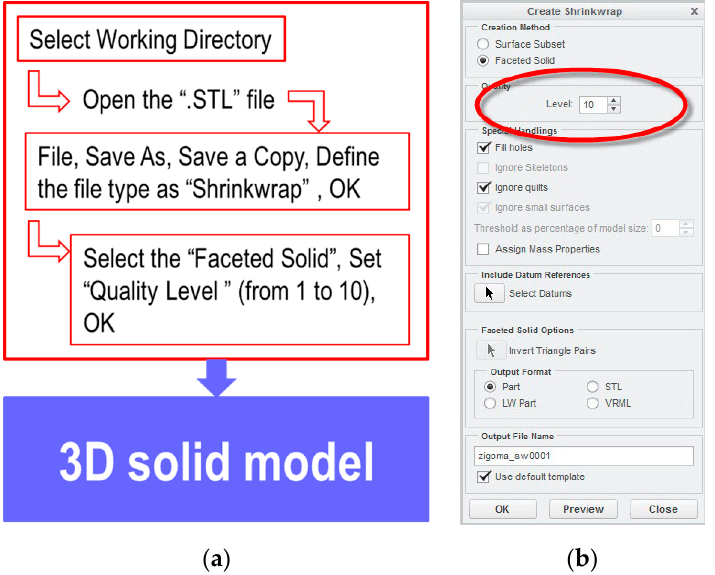
Figure 4. Steps for converting the STL files into 3D solid models using Creo: ( a ) stages of conversion using the Shrinkwrap function; ( b ) settings to obtain a solid model.